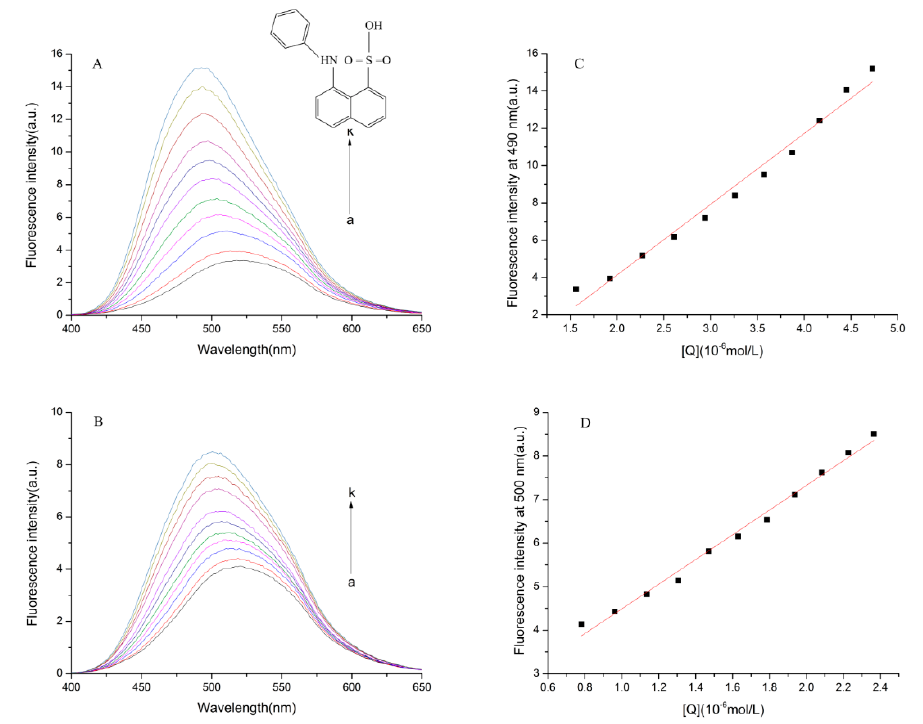
Figure 7. The structure of ANS. Fluorescence emission spectra of bLf-ANS system ( A ) and bLf-TCH-ANS system ( B ) with different concentration of bLf. Variation in relative fluorescence intensity of bLf-ANS ( C ) at 490 nm and bLf-TCH-ANS ( D ) at 500 nm with different concentration of bLf, c (TCH)/c (bLf) = 1:1.